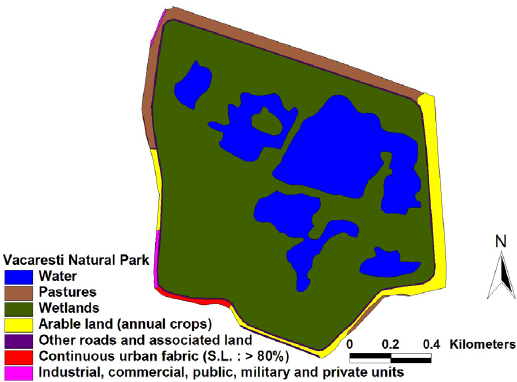
Figure 6. Land cover of Vacaresti Natural Park based on 2018 Urban Atlas data. The image shows that most of the area is occupied by water and wetlands.